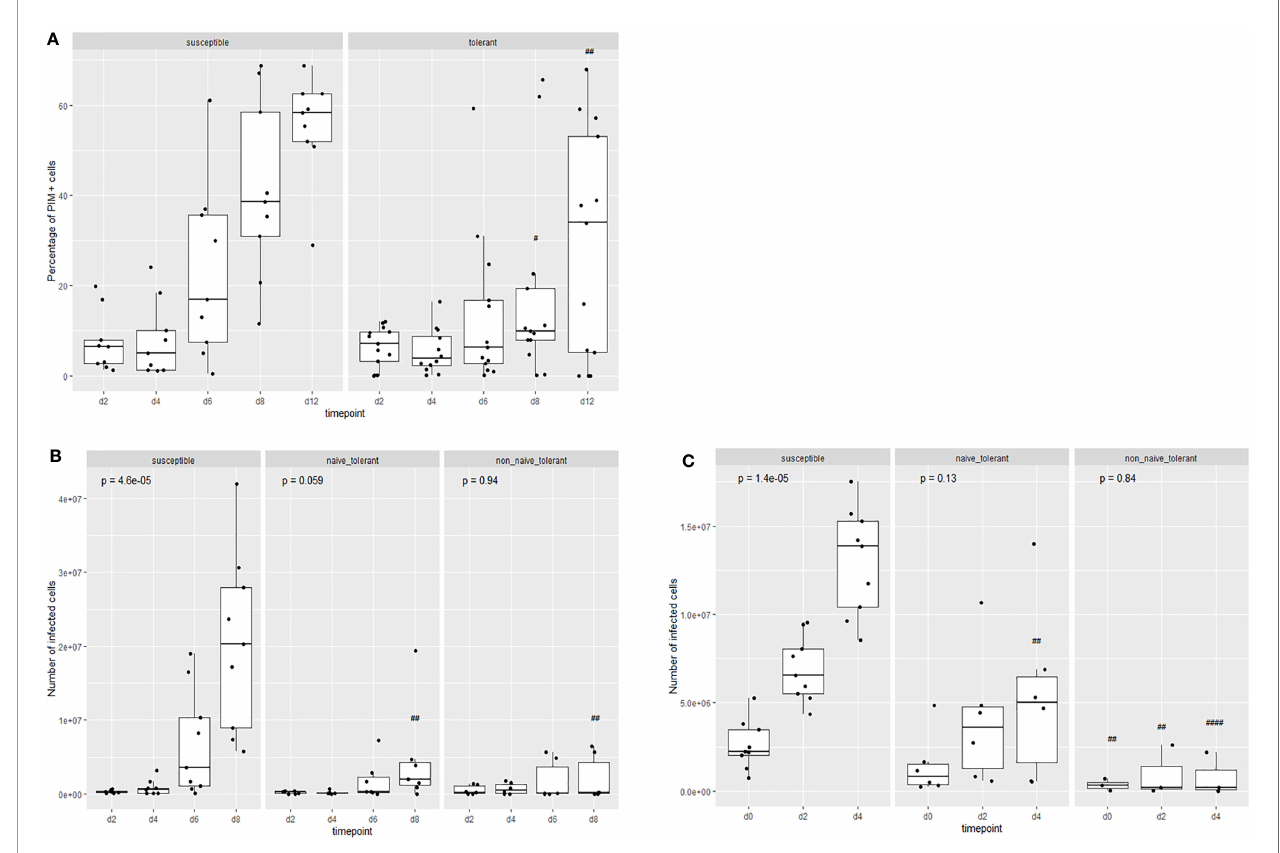
FIGURE 3 | Proliferation of live infected (PIM+) cells from tolerant and susceptible animals. Change in the proportion (A) and numbers (B, C) of live infected cells in cultures from tolerant and susceptible animals during the fi rst (B) and second (C) week of culture after infection in vitro . The results are the means of cell lines from 13 surviving animals and 9 susceptible animals. The p values represent the probability of a difference in the values at different days within each group (Kruskal-Wallis test). The probability of a difference in values on the same day between susceptible and tolerance populations is shown as ## p < 0.01; #### p < 0.0001 (Wilcoxon